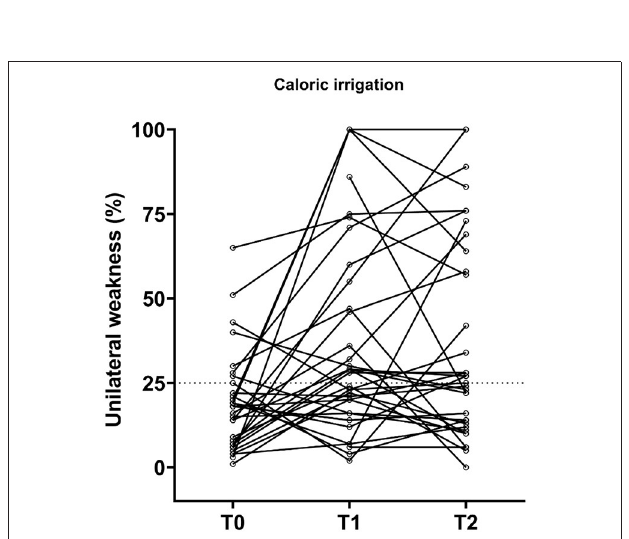
FIGURE 5 | Individual changes in caloric function before implantation and at the postoperative follow-ups. T0, baseline before implantation; T1, first postoperative follow-up; T2, second postoperative follow-up. Observations above the dotted line represent vestibular hypofunction (UW = 25%); UW = 100% means